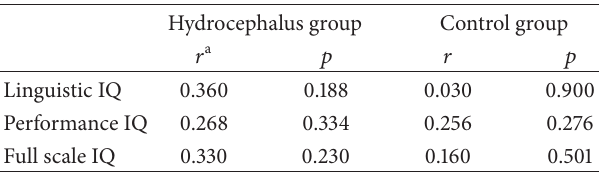
Table 5: Relationship between mean cortical thickness of the left rostral middle frontal and IQ.